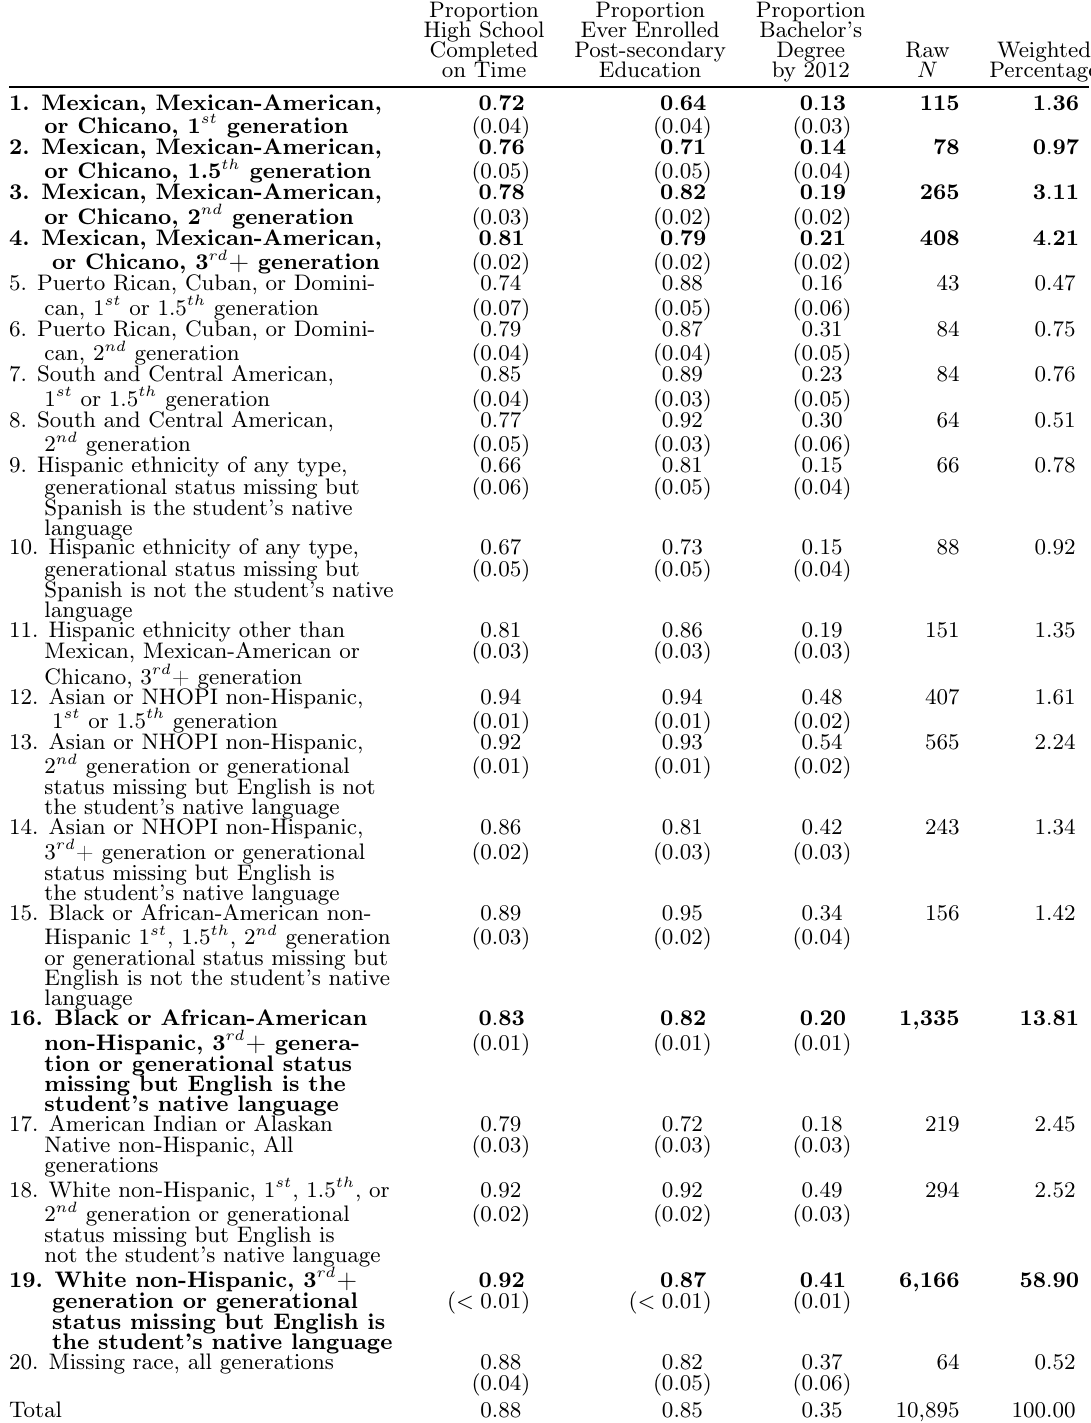
Table 1: Educational Attainment Patterns by Race-Ethnicity and Immigrant Generation Proportion Proportion Proportion High School Ever